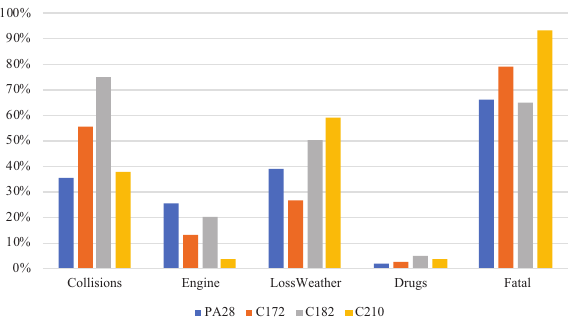
Figure 2. Percentage of events contributing to wing separations and fatalities in PA28s, C172s, C182s, and